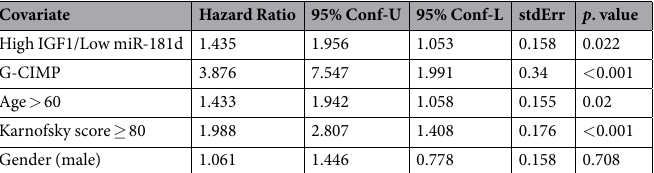
Table 2. Statistical calculations for high IGF-1/low miR-181 status. IGF1-miR-181 status is a strong and independently significant prognostic factor among Karnofsky performance status, age, gender and CIMP status. stdErr: stander error; Conf-L/U: Confidence interval lower limit/upper limit.